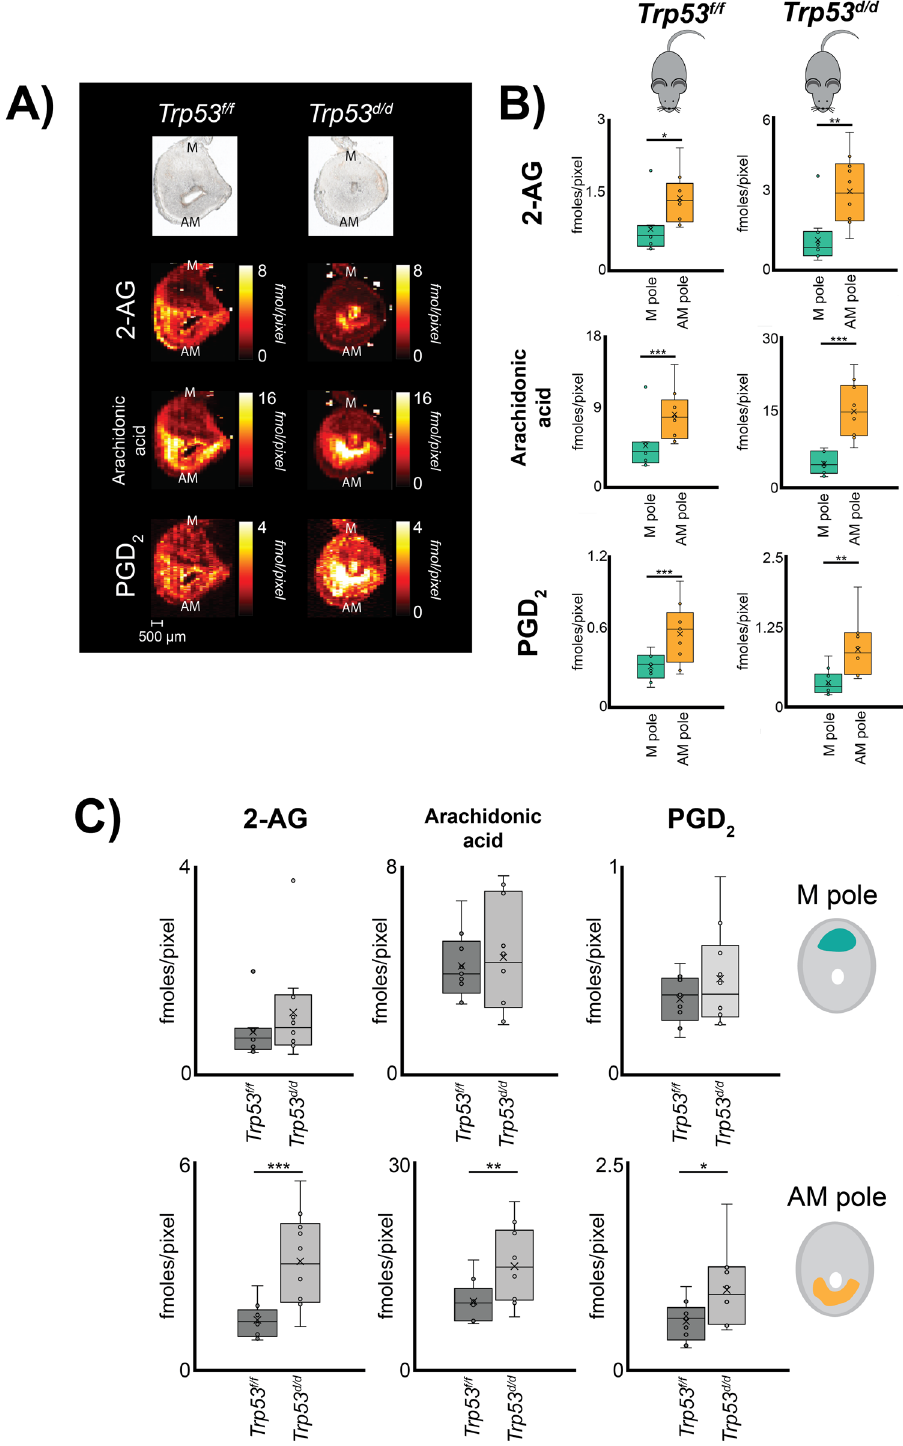
Fig. 2 Distribution of prostaglandins to morphological regions in mouse embryo implantation sites on day 8 of pregnancy using quantitative silver doped nano-DESI MSI. A Optical images and corresponding quantitative ion images of 2-AG, arachidonic acid, and PGD 2 in Trp53 f/f and Trp53 d/d mice on day 8 of pregnancy. Color scaling corresponds to detected fmoles/pixel with the values going from dark to bright. Note that the fi xed quantitative color scales for each metabolite facilitates direct visual comparisons. Scale bar 500 µ m. M mesometrial pole; AM anti-mesometrial pole. B Regions of interest for the AM-pole and M-pole of Trp53 f/f and Trp53 d/d mice, respectively, with detected concentrations of 2-AG, arachidonic acid, and PGD 2 from three biological and three technical replicates. C Region of interest analysis of the AM-pole and M-pole for 2-AG, AA, and PGD 2 of 3 biological and 3 technical replicates comparing the of Trp53 f/f and Trp53 d/d mice ( n = 9 for each genotype). Error bars in represent 1 standard deviation and * p -value < 0.05, ** p -value < 0.01, *** p -value <